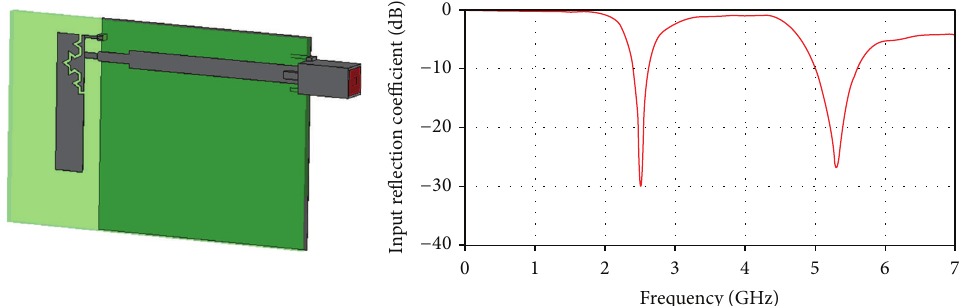
Figure 2: The computational model of the dual-band K2 PIFA in perspective and the magnitude of its input reflection coefficient in the range DC-7GHz.